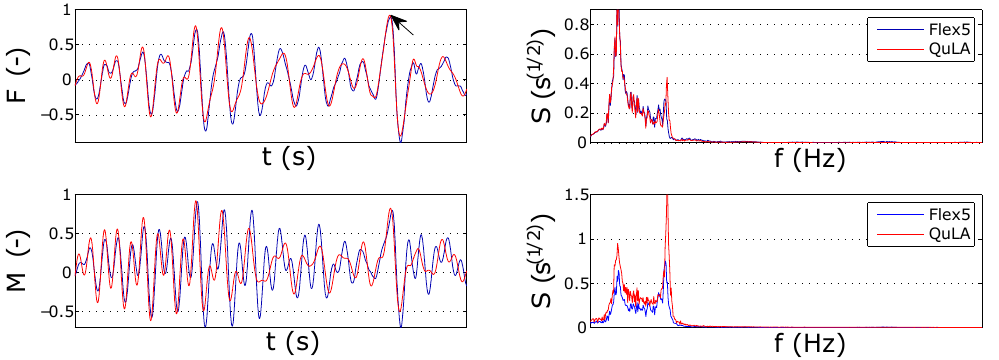
Figure 20. Sectional force and moment at the seabed for load case 6.1. The force and moment time series are normalized with the largest force and moment at the seabed in the Flex5